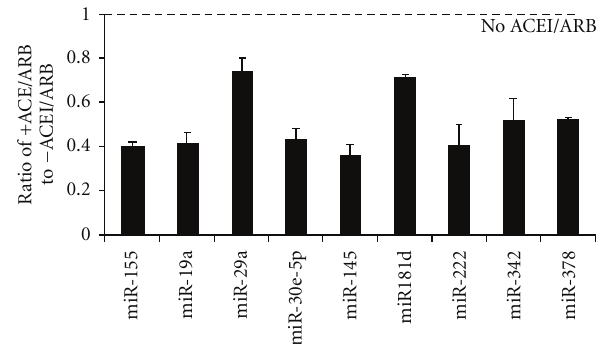
Figure 3: Medications influence the circulating levels of specific miRNAs. Expression data obtained from the patients (angiograph- ically significant CAD or ≥ 2 CAD risk factors but no significant CAD lesions) on ACEI or ARB compared to similar patients not on ACEI or ARB. Circulating levels of miR-155, miR-19a, miR- 378, miR-222, miR-342, miR-145, and miR-30e-5p were decreased in patients who were taking these medications. P values: miR-155 = .0007, miR-19a = .035, miR-29a = NS, miR-30e-5p = .011, miR- 145 = .003, miR-181d = NS, miR-222 = .002, miR-342 = .0036, and miR-378 =